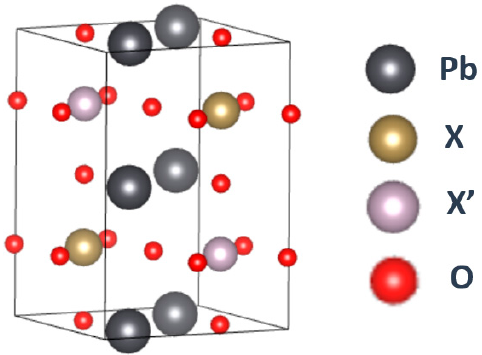
Figure 1. An ideal ordered double perovskite structure of Pb 2 XX ′ O 6.